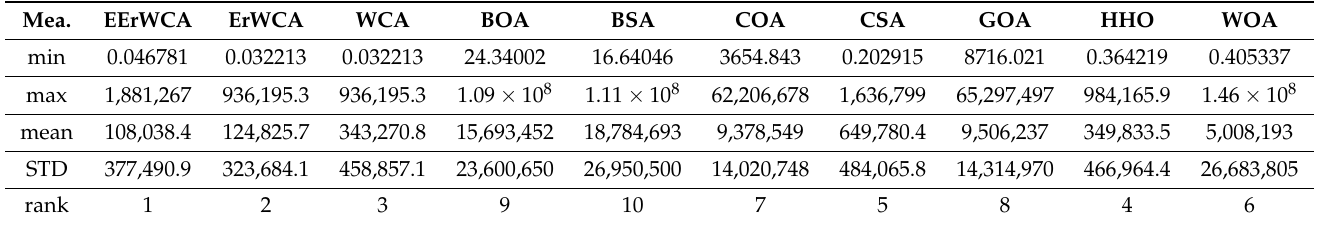
Table 5. Statistical results of EErWCA versus other metaheuristics on optimal design of industrial refrigeration system.